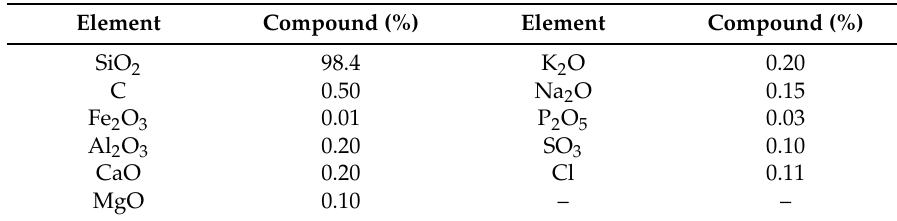
Table 2. Chemical analysis of micro-silica.